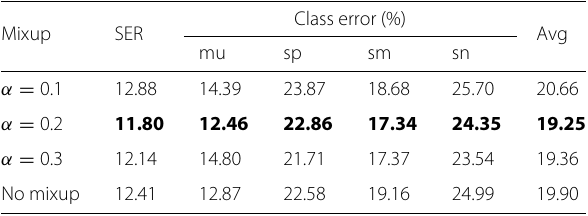
Table 9 SER, error per class and average class error on the test N = 10) trained with mixup augmentation with hyperparameter